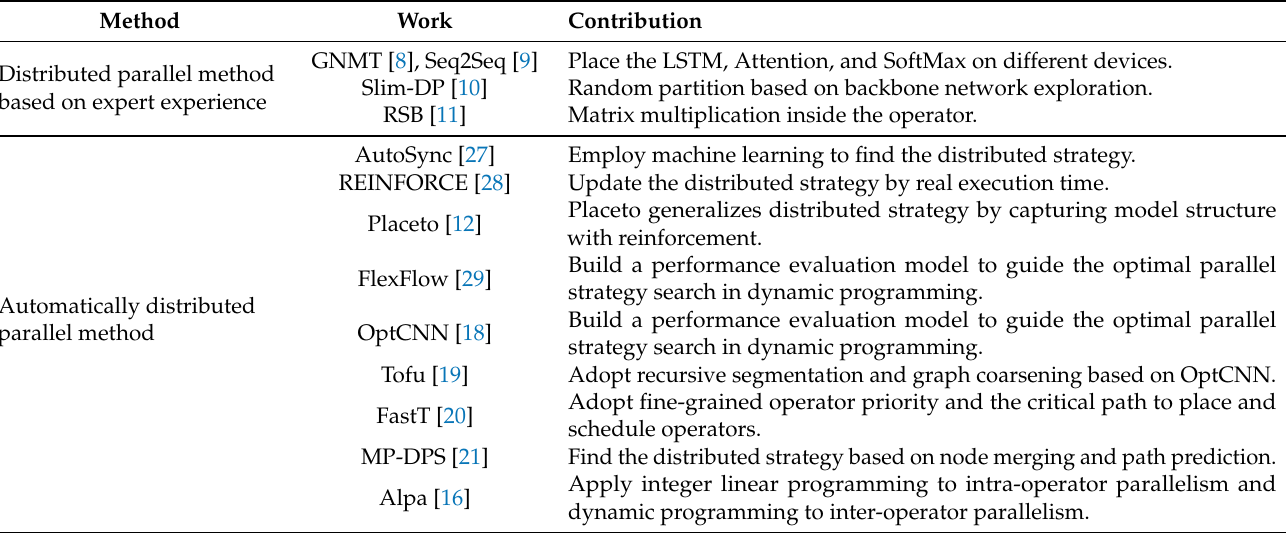
Table 2. Distributed Parallel